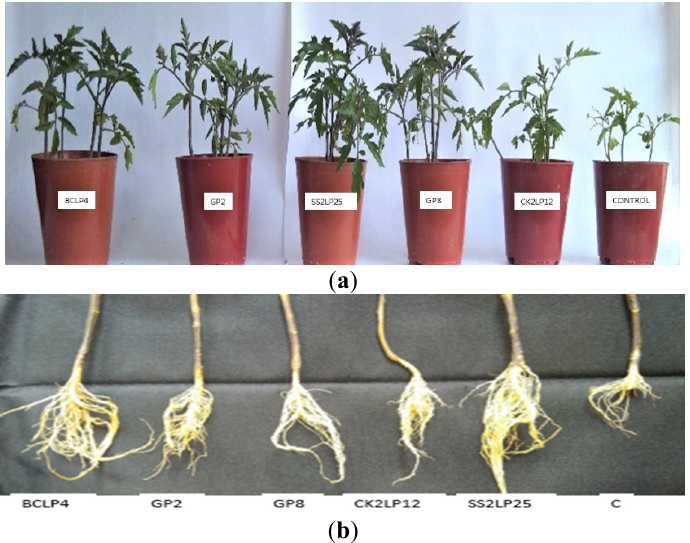
Figure 4. Enhancement of shoot length (a) and root length (b) of tomato plants after treatment with selectesd lateritic Pseudomonads. Table 9. Impact of native lateritic Pseudomonads on tomato plants in terms of germination, plant growth and disease